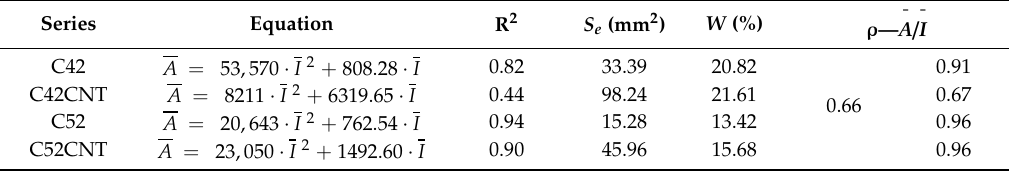
Table 4. Equations of the functional curves describing the A W —diagnostic statistics; ρ —correlation coe ffi